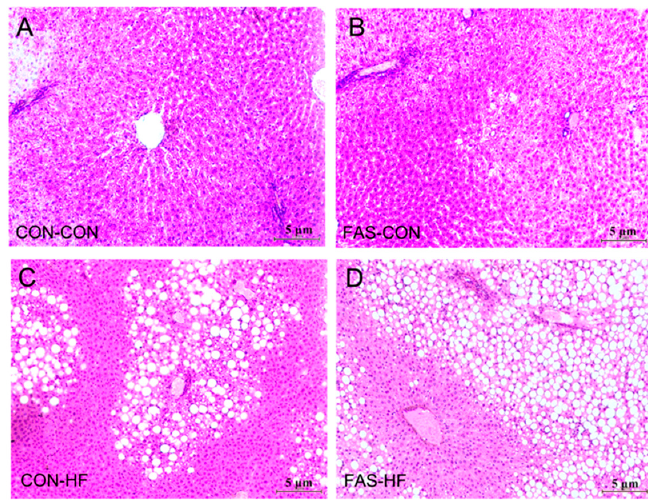
Figure 3. H&E stains of representative liver sections of male: CON-CON ( A ); FAS-CON ( B ); CON-HF ( C ); and FAS-HF ( D ) offspring at 15 weeks (40×).